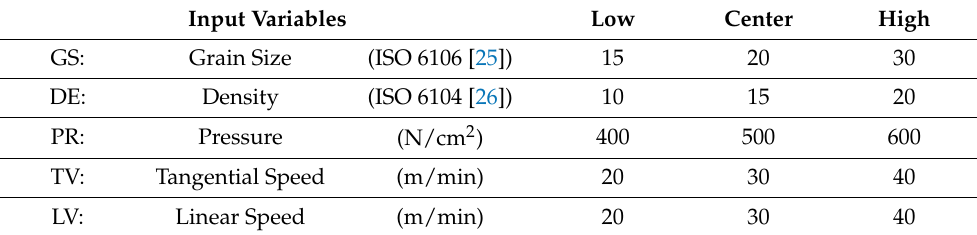
Table 1. Levels of the input